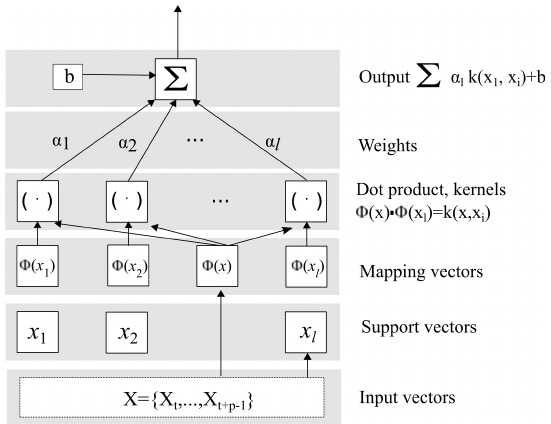
Figure 4. SVM functional structure [28].